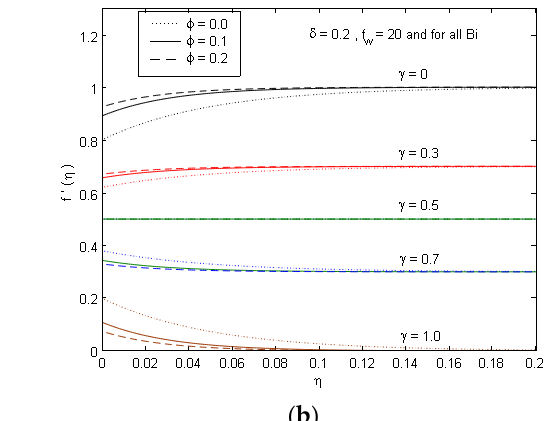
Figure 6. Velocity profiles for different values of ( a ) suction parameter f w and ( b ) solid volume fraction parameter φ at different values of γ .